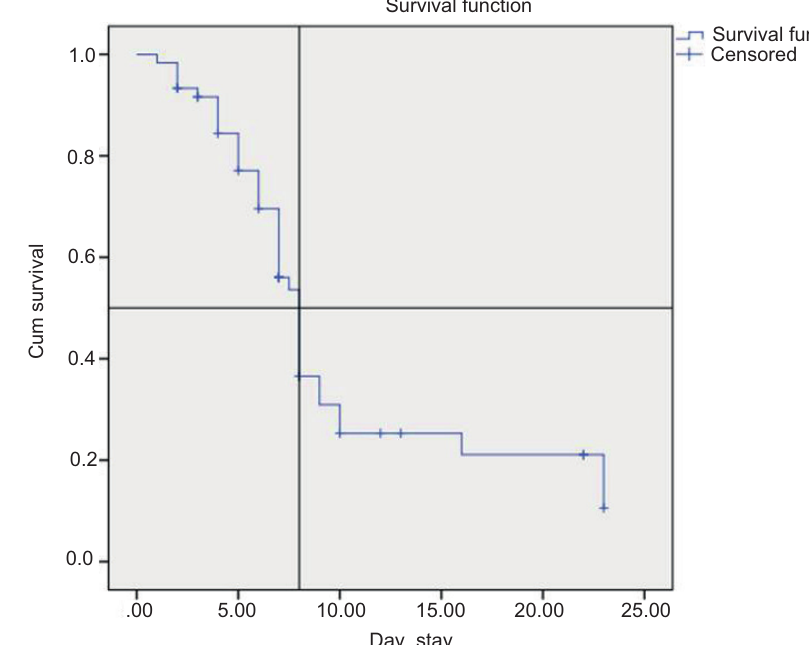
Figure 1: The probability of surviving 8 days in hospital stay is 50%.